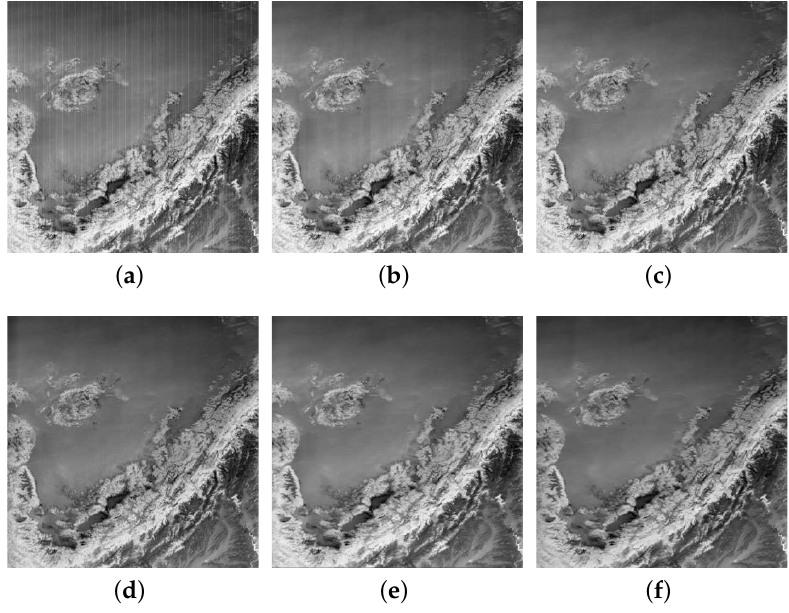
Figure 11. Destriping results of periodic stripes in Terra MODIS band 30. ( a ) Original image; ( b ) WAFT; ( c ) SLD; ( d ) GSLV; ( e ) LRSID; ( f ) the proposed